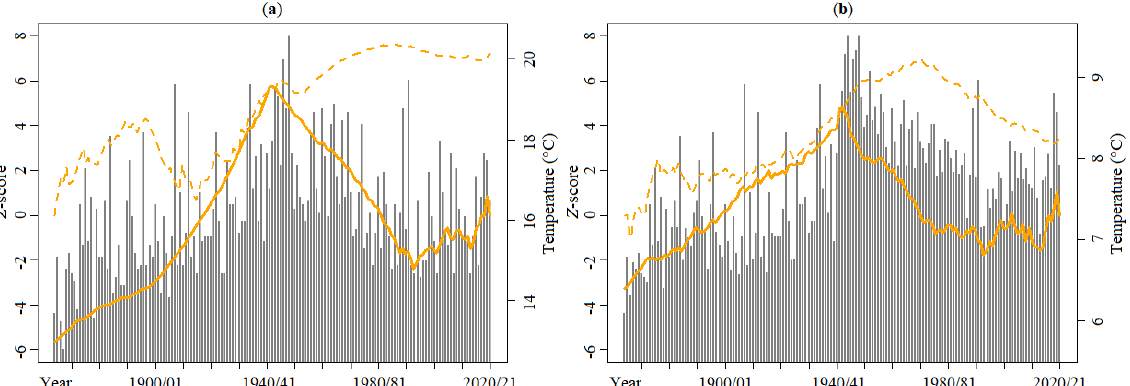
Figure 13. Sequential Mann–Kendall test applied to the annual series, from 1864/65 to 2020/21, of: ( a ) average and ( b ) daily maximum diurnal temperature range (DTR) values. The progressive u ( t ) (solid orange line) and retrograde u (cid:48) ( t ) (dashed red line) trend series of DTR are derived from the corresponding DTR values (grey